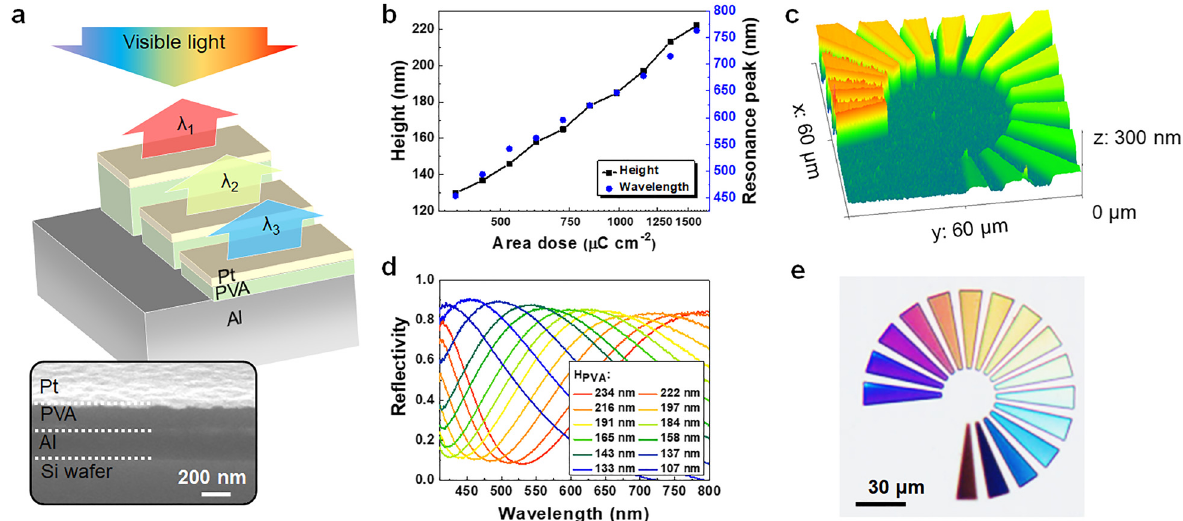
Figure 1: (a) Schematics of the proposed MIM microstructure with the varied insulator thickness for multi-color displays. Inset shows the cross-section SEM image of Pt/PVA/Al (thickness: 27 nm/140 nm/150 nm, respectively) layers on a Si wafer. (b) Height of exposed PVA and re fl ective resonance of the corresponding MIM structures with varied EBL exposure dose. (c) Height map tested by AFM for patterned MIM structure. (d) Re fl ection spectra of MIM structure containing the PVA layer with the thickness varied from 107 to 224 nm, and the top Pt layer with the thickness of 14 nm. (e) Photograph of the patterned MIM structure showing multi-color display with increased thickness from 107 to 224